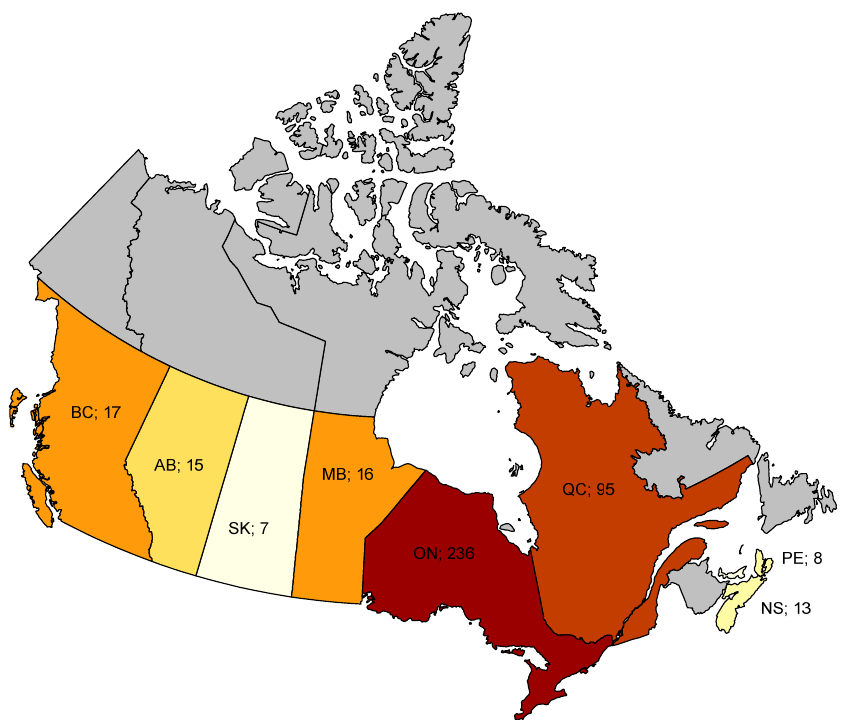
Figure 1. Number of respondents by province. The figure shows the number of survey participants for each Canadian province with more than five participants. It includes respondents who did not complete the entire questionnaire.